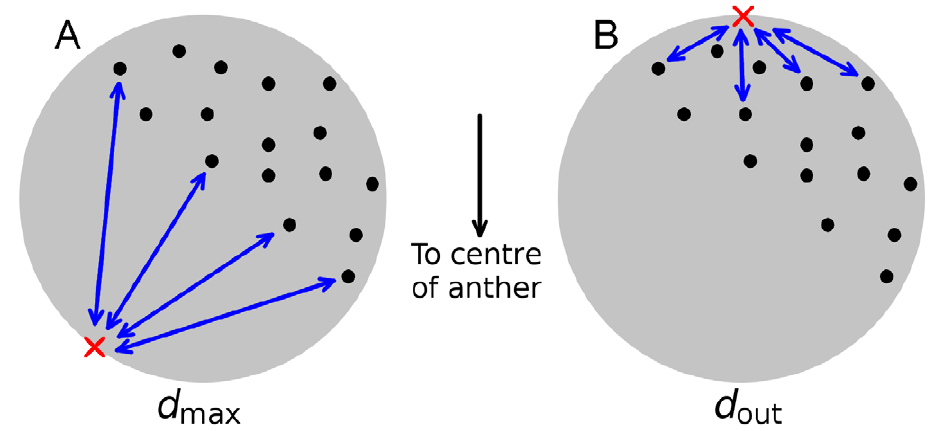
Figure 3. Sketch of the definitions of d max and d out . Both quantities are the average distance between the telomere clusters and some other point weighted by the telomere cluster intensities, i.e. the weighted average of the lengths of the blue arrows. Although only some blue arrows are shown, the averages are taken over all telomere clusters. A. For d max the relevant distance is that between the telomere clusters and the point on the nuclear envelope (red cross) that maximises the average distance. B. For d out the relevant distance is that between the telomere clusters and the ‘‘outside’’ pole (red cross), i.e. the point on the nuclear envelope that is furthest from the centre of the anther.